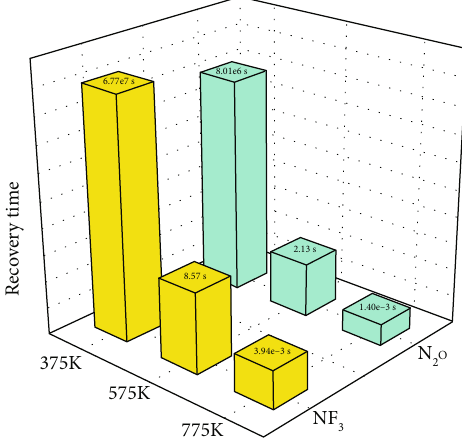
Figure 12: Desorption time at di ff erent